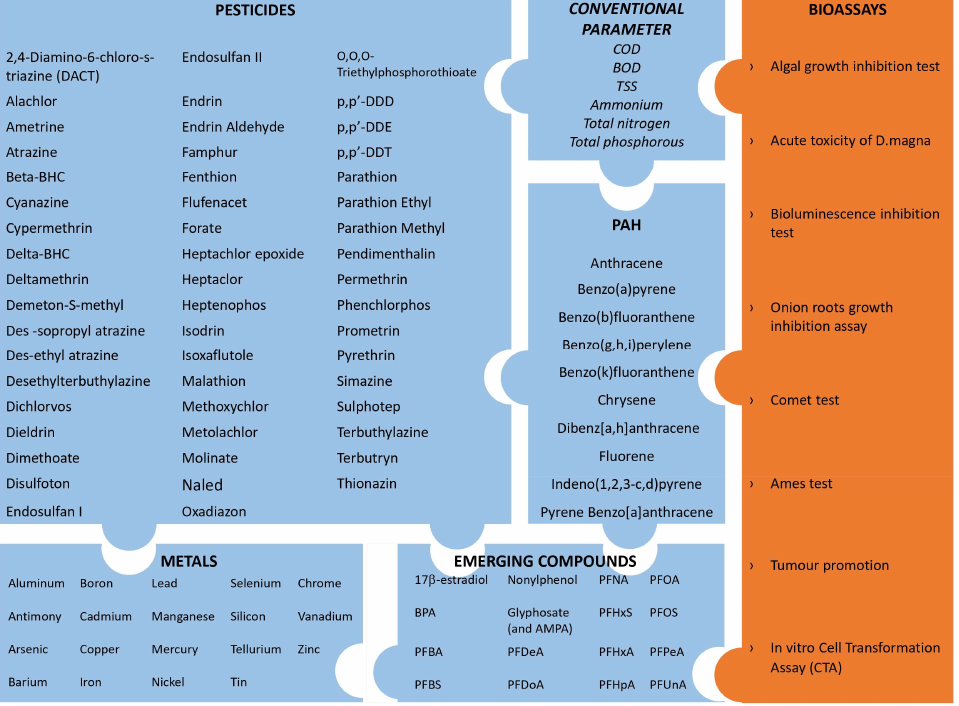
Figure 2. Subsets of compounds analyzed and bioassays used in the life cycle inventory assessment.